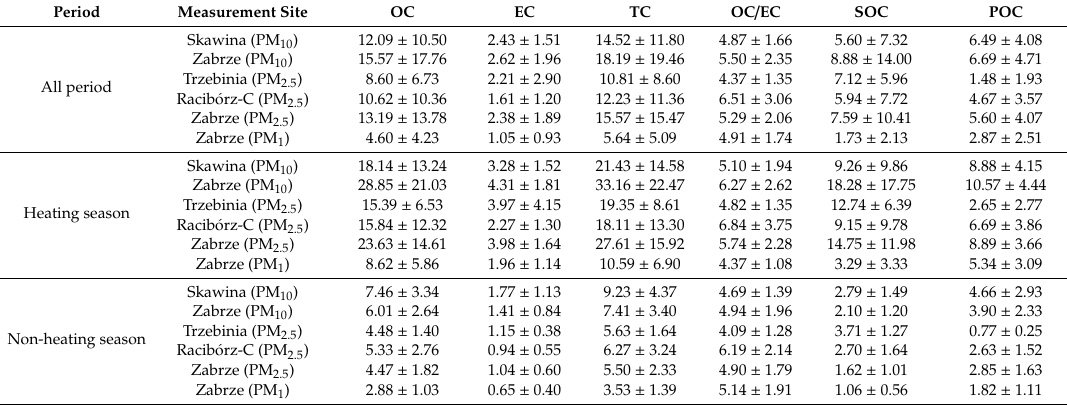
Table 4. Average concentrations of carbonaceous compounds ( µ g · m − 3 ), along with the average values of the OC / EC ratio at considered urban background